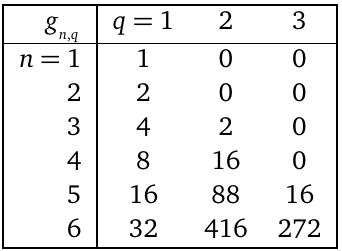
Table 2: The degeneracies encountered in embedding a particular n -point function of proper q -OTO type, into a generic k -OTO contour for low-lying values of n . h ( q ) q = 1 2 3 n , k n = 1 2